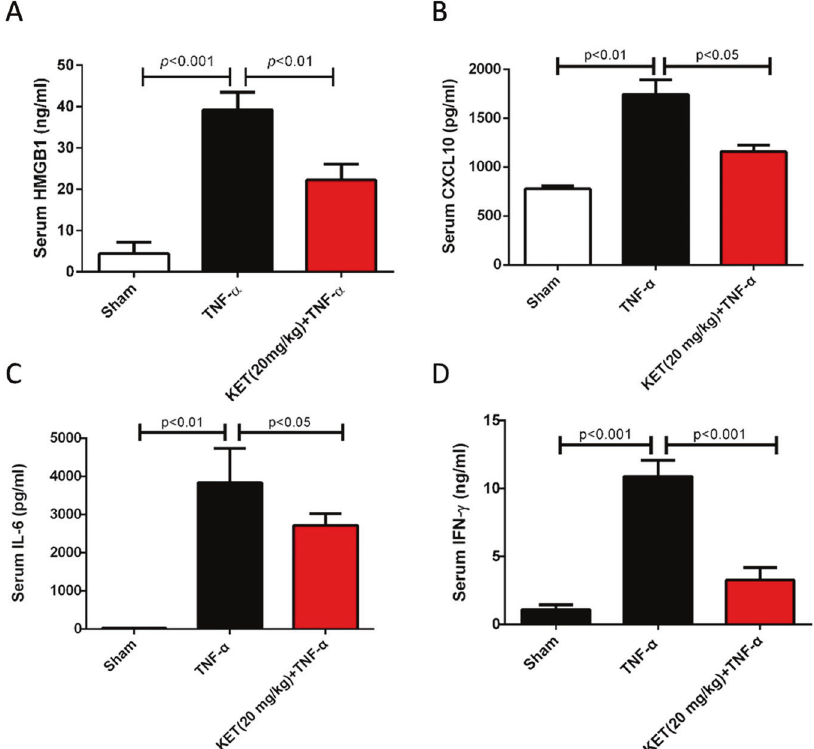
Fig. 2 Ketamine decreased the expression of in fl ammatory cytokines in mouse serum. A Serum HMGB1 from mice with indicated treatment was measured at 12 h after TNF- α administration by HMGB1 ELISA kit. B Serum CXCL10 from mice with indicated treatment was measured at 12 h after TNF- α administration by CXCL10 ELISA kit. C Serum IL-6 from mice with indicated treatment was measured at 12 h after TNF- α administration by IL-6 ELISA kit. D Serum IFN- γ from mice with indicated treatment was measured at 12 h after TNF- α administration by IFN- γ ELISA kit. All data are shown as the mean ± SEM. n =